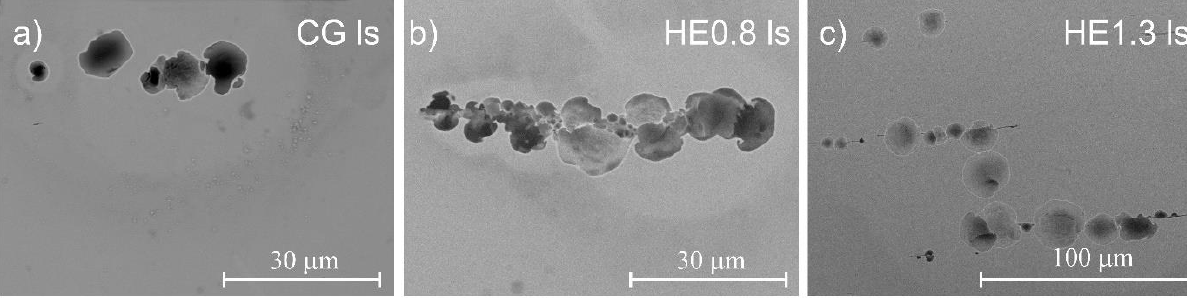
Figure 7. Post-corrosion morphology of the corrosion attack after potentiodynamic polarization in borate buffer solution with chloride ions on the longitudinal section of ( a ) CG, ( b ) HE0.8 and ( c ) HE1.3 samples.